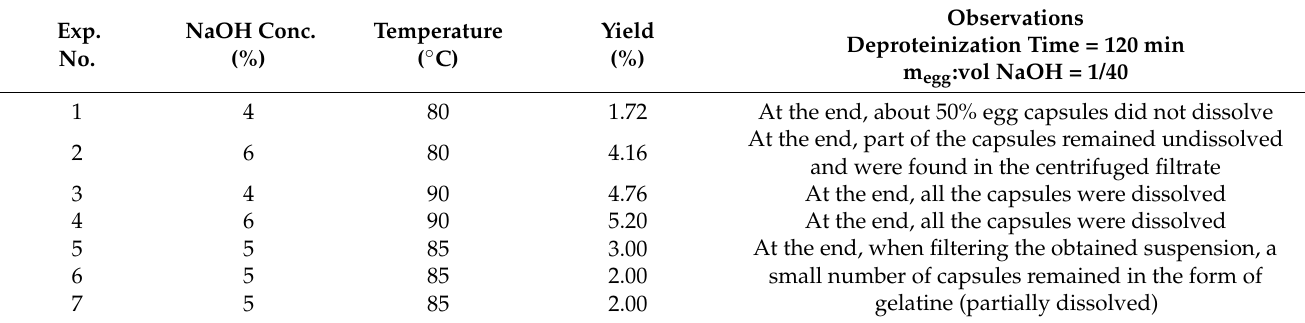
Table 1. Yields values for the initial 2 2 experimental plan, considering an extraction time of 120 min.